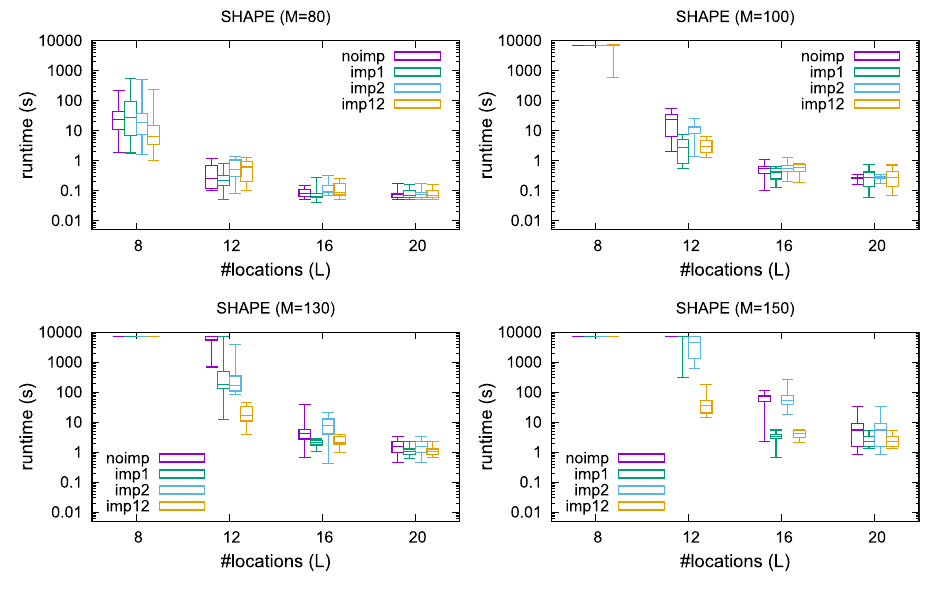
Fig. 2 PAR1 (in seconds) of solving some random B2B fam- ilies of instances, with and with- out using implied constraints, varying their shape s . Instances are generated using the P = 40 B2Brand model with , T = 20 L = { 8,12,16,20 } , , M = 80 and (i) (top left), (ii) M = 100 (top right), (iii) M = 130 (bottom left), and (iv) M = 150 (bottom